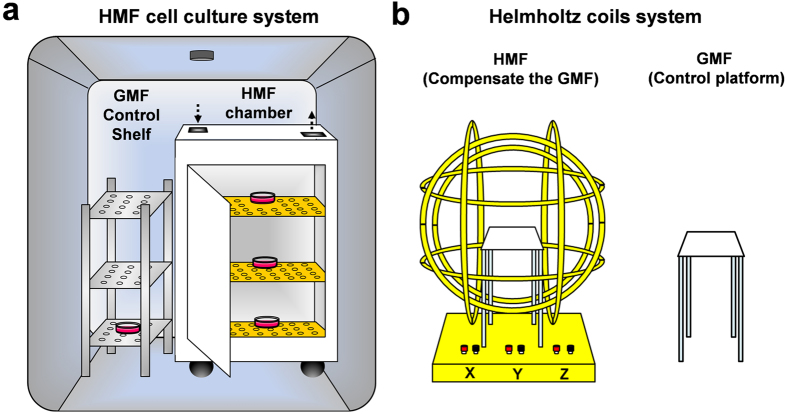
Simulation of the HMFs.(a) A permalloy magnetic shielding chamber is settled in a cell incubator and provides a <200 nT HMF condition for cell culture. The GMF control cells are placed on the bottom layer of a steel shelf aside the permalloy chamber. (b) A three-axis Helmholtz coils system compensates the GMF at the center of the system and provides a <500 nT HMF condition for in vitro actin assembly. The GMF control samples are placed on a platform outside the coils system.